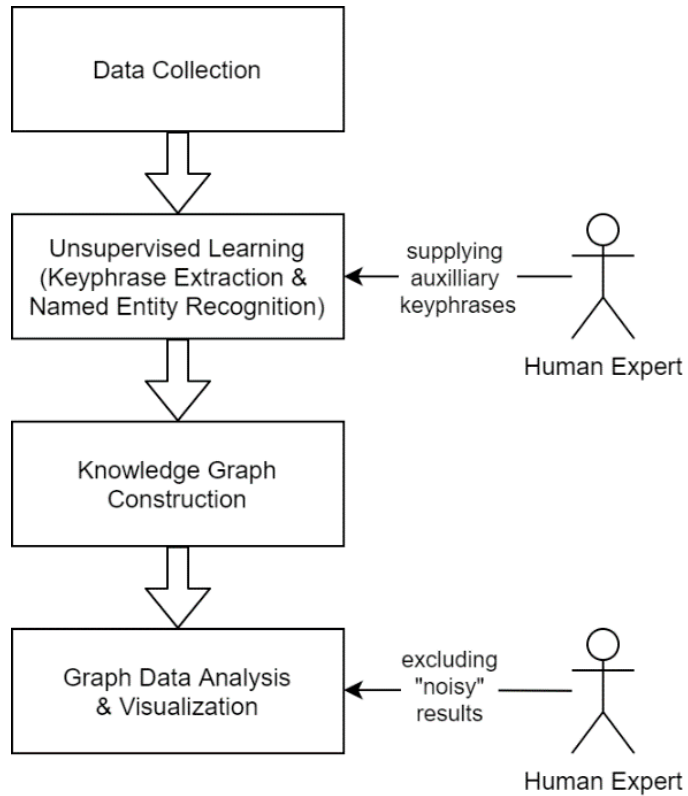
Figure 1. Overview of the proposed approach.